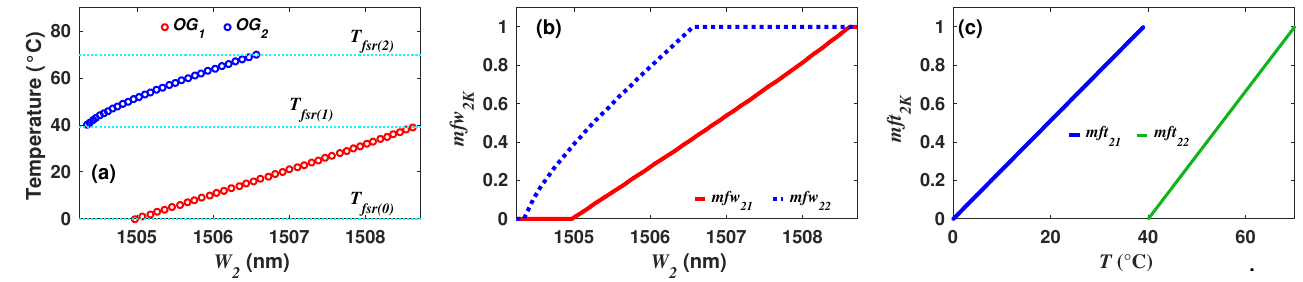
Figure 6. ( a ) Wavelength positions W 2 of peak P 2 as a function of temperature, and observations forming two groups corresponding to each one of the observed FSR periods; ( b ) membership functions mfw 2 K used to fuzzificate the wavelength position ( W 2 ) of fringe’s peak P 2 ; ( c ) membership functions wft xK ( T ) to evaluate the fuzzy rules